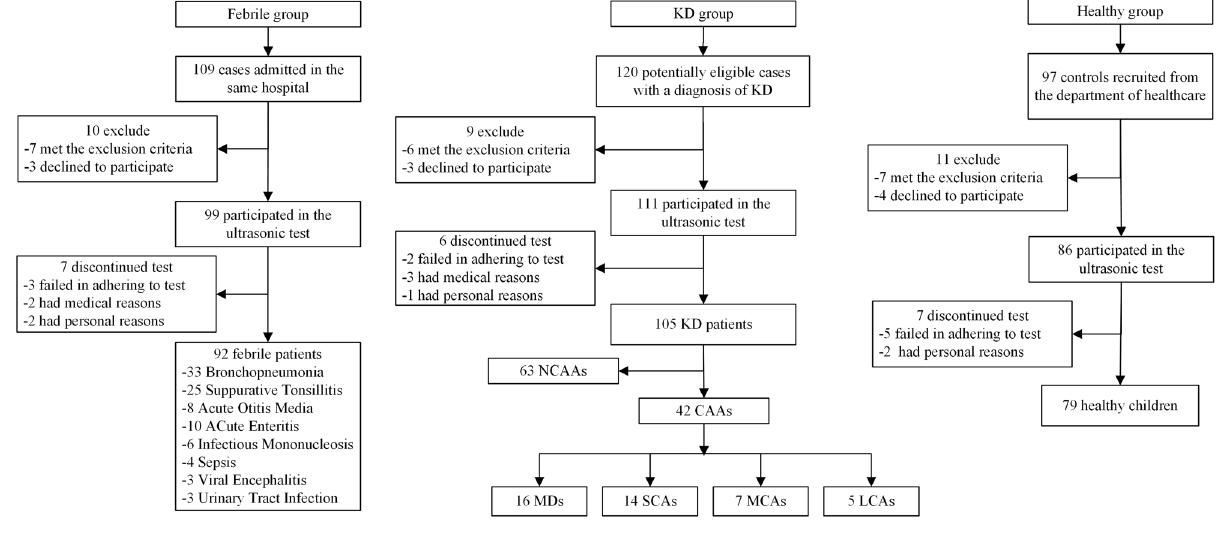
Figure 1. Participant flow diagram.